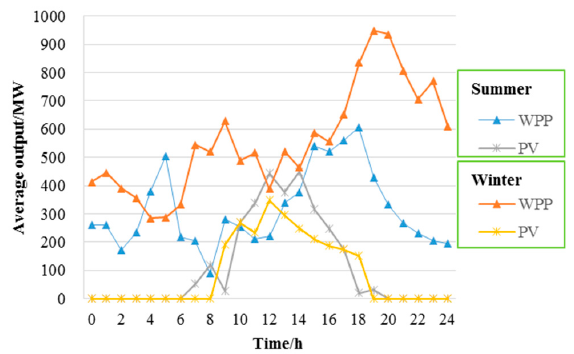
Figure 6. The average outputs of WPP and PV on a typical load day (summer and winter).